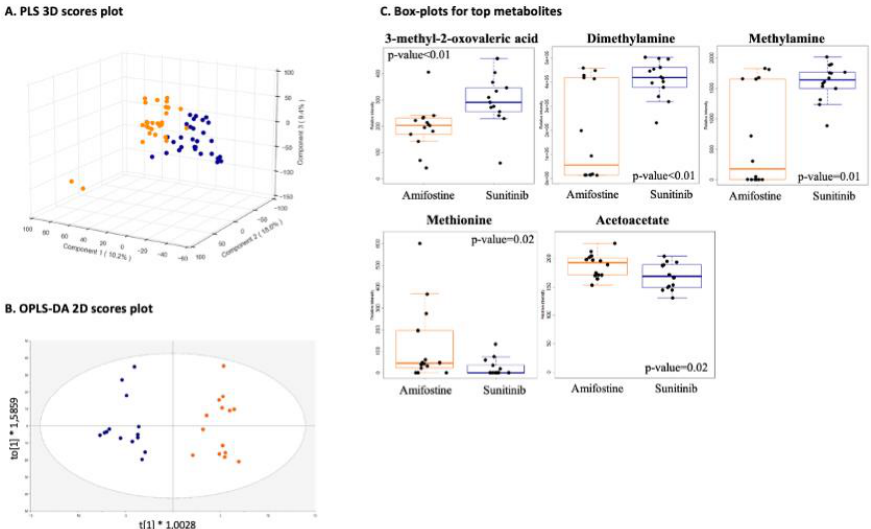
Figure 3. Drug-specific anti-angiogenesis profiling. (group comparison-c; amifostine_deferoxamine_VEGF-A, n = 28 vs. sunitinib_deferoxamine_VEGF-A, n = 28). ( A ) PLS 3D scores with R2 greater than 0.9 and Q2 equal to 0.8 using five components; ( B ) OPLS-DA 2D scores plot; ( C ) boxplots of top metabolites and their p -values. Group comparisons are color-coded; orange, angiogenesis stimulation and blue, angiogenesis inhibition.